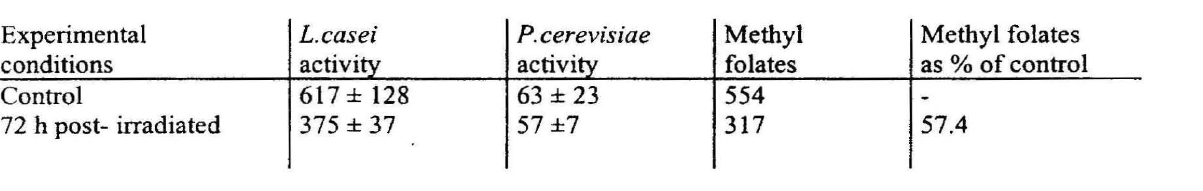
(see text). Values are mean ± SEM for four mice in each